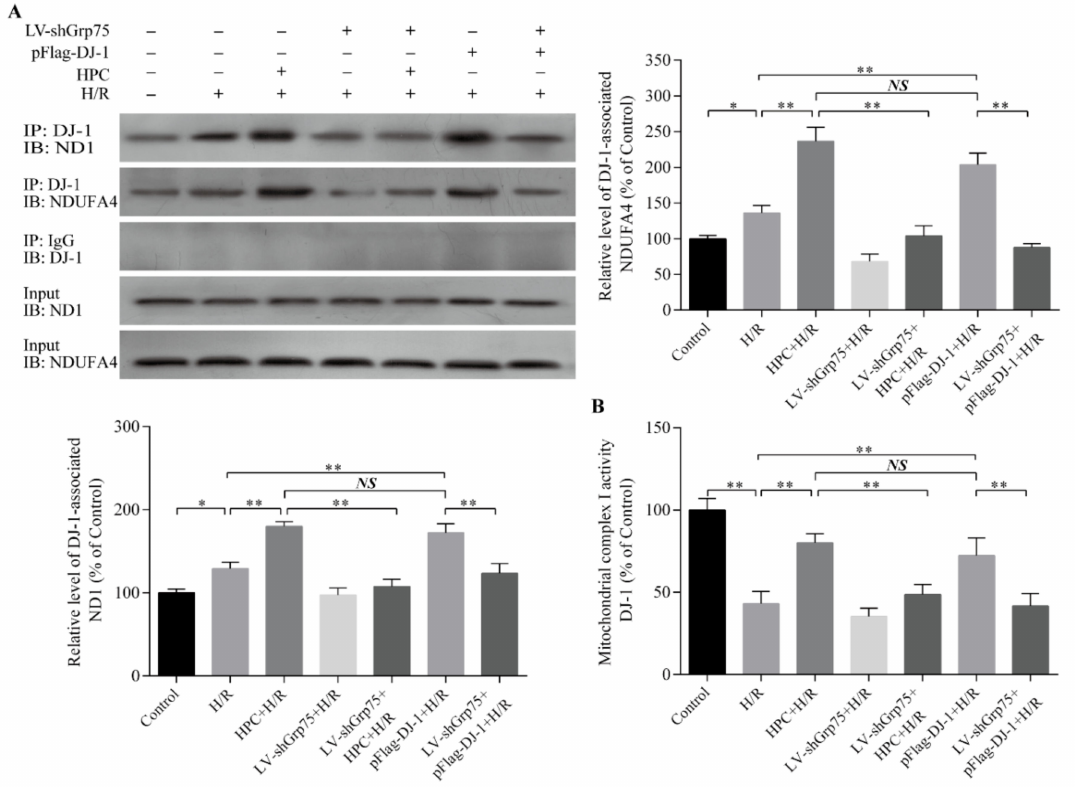
Figure 5. E ff ect of Grp75 knockdown on the association of DJ-1 with ND1 and NDUFA4 subunits and the protection of mitochondrial complex I activity by hypoxic preconditioning (HPC) in H9c2 cells subjected to hypoxia / reoxygenation (H / R). H9c2 cells were infected by lentiviral (LV) vectors LV-shGrp75 for 72 h and then subjected to HPC 24 h prior to H / R or transfected with pFlag-DJ-1 for 48 h followed by H / R. Subsequently, ( A ) the association of DJ-1 to NDUFA4 and ND1 was assessed by coimmunoprecipitation. Mitochondrial lysates were immunoprecipitated (IP) with anti-DJ-1 antibody, and immunoblot (IB) analysis was performed with anti-NDUFA4 or anti-ND1. Total protein extracts (prior to IP) were used as control (Input) and IgG-precipitated template served as specificity control. Representative blots from three independent experiments and bar graphs from their densitometric analyses are shown. The data are presented as mean ± SD. * p < 0.05, ** p < 0.01 as indicated on the figure. ( B ) The enzyme activity of mitochondrial complex I was determined as described in Materials and methods section. Each value represents the mean ± SD of three independent experiments. ** p < 0.01 as indicated on the figure. NS indicates no